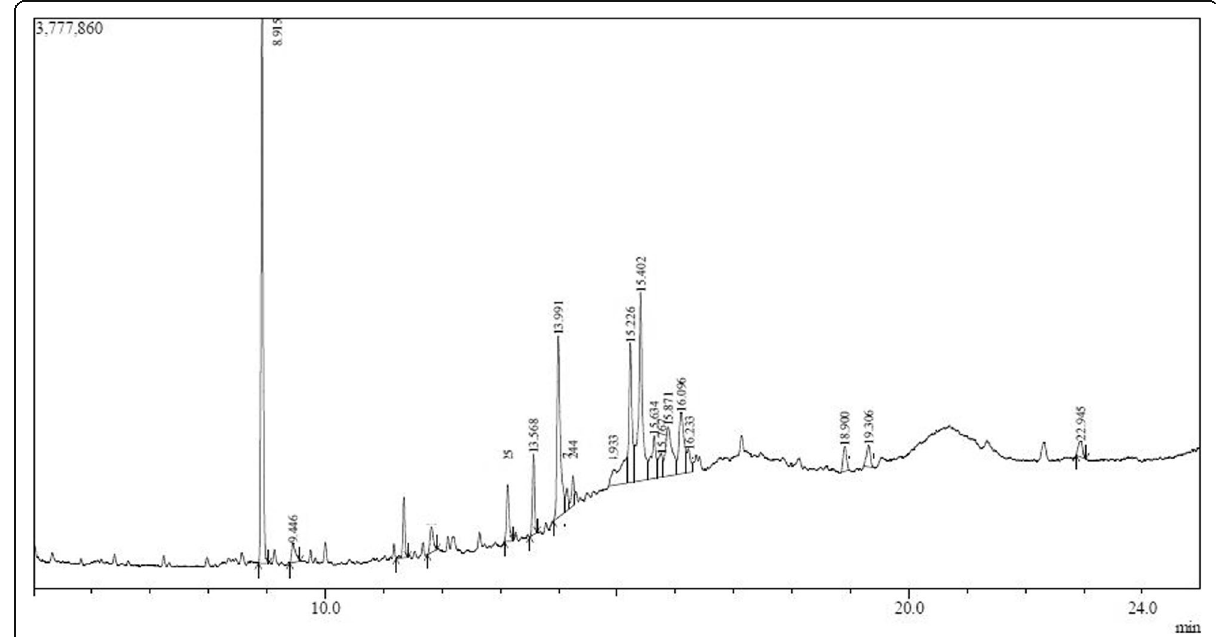
Fig. 5 Chromatogram of bioactive fraction extracted from Cinnamomum cappara